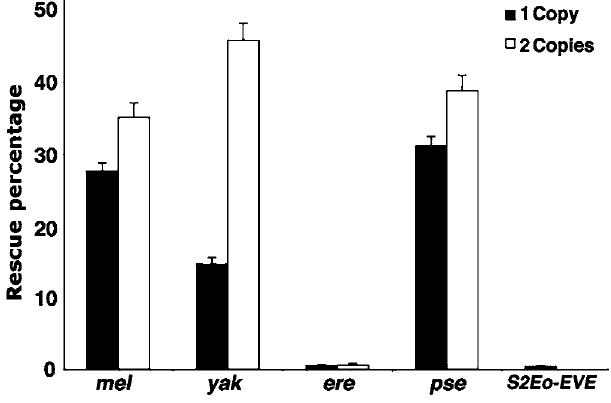
Figure 4. Rescue to Adulthood of eve Null Mutants Rescue percentages to adulthood of EVE D S2E homozygotes with one or two copies of rescue construct from the four species, and the negative control, denoted on x-axis. Each bar represents percentages summarized over sexes and reciprocal crosses (full data in Table S1). DOI: